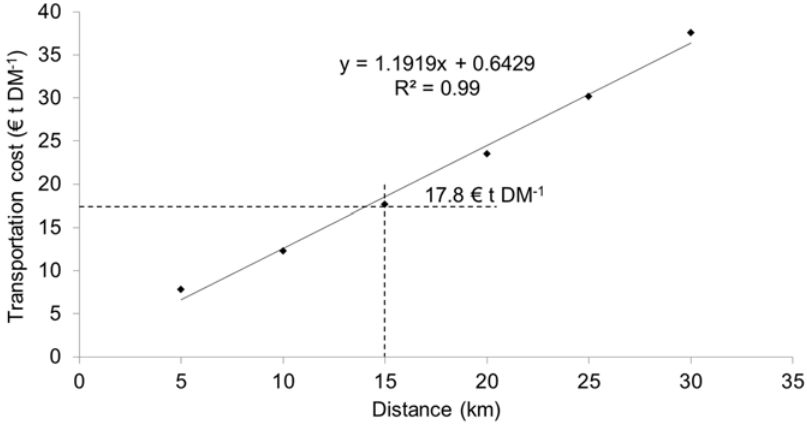
Figure 6. Transportation cost as a function of distance.